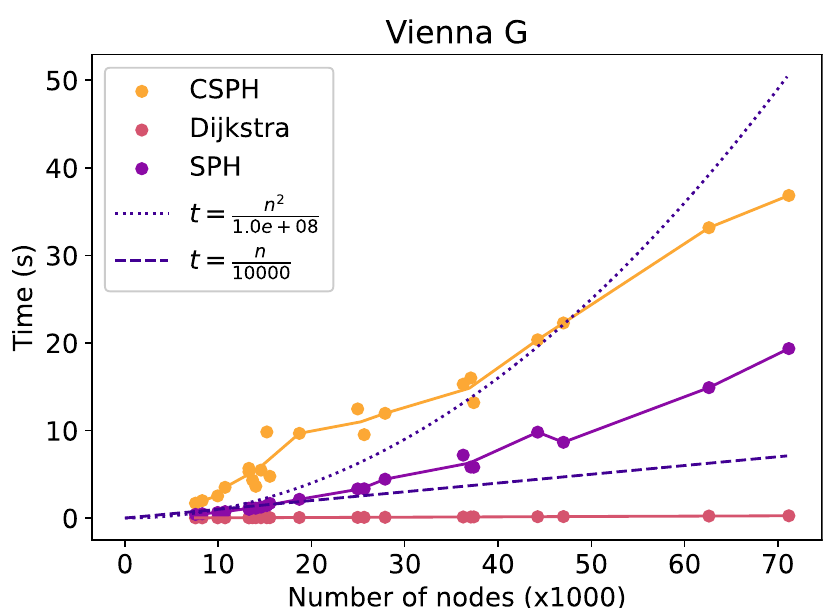
Fig 6. Vienna G time evolution by method. Evolution of the time cost of Dijkstra, SPH and CSPH. Includes a quadratic and linear function to compare trends.